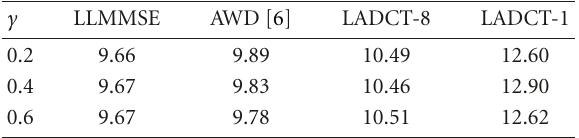
Table 6: SNR results for Barbara, degraded with film-grain type of noise at 2.9dB